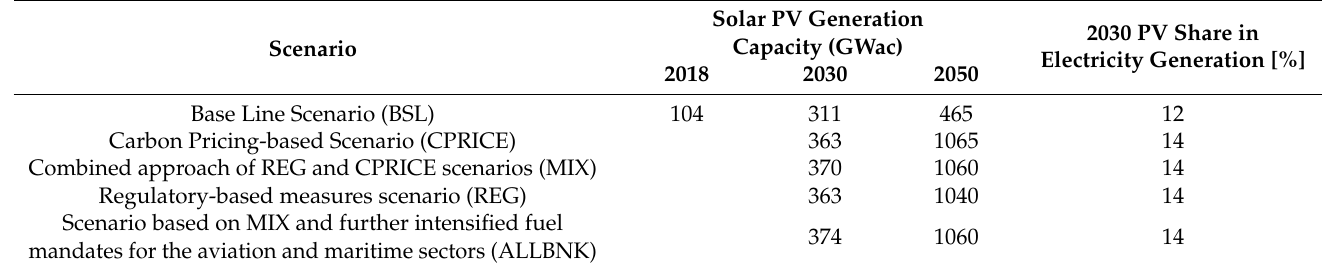
Table 2. Energy model projections for solar PV capacity deployment in EU 27